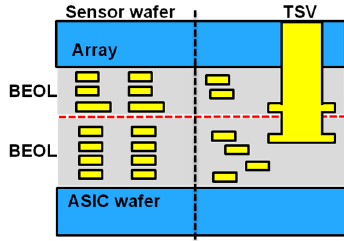
Figure 1. First-generation BSI-CIS stacking with oxide-oxide bonding and TSV.